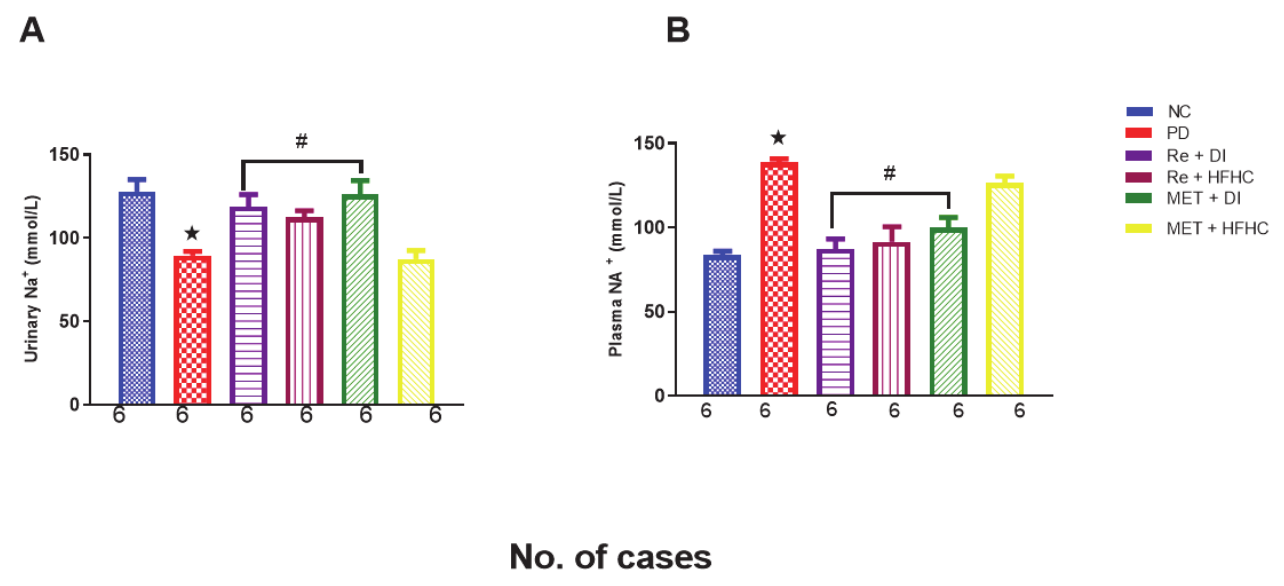
Figure 13. ( A , B ) Urinary and plasma NA + concentration in normal control (NC), prediabetic control (PD), metformin and diet intervention (MET + DI), metformin and high-fat/high-carbohydrate diet (MET + HFHC), rhenium (V) compound and diet intervention (Re + DI) and rhenium (V) compound and high-fat/high-carbohydrate diet (Re + HFHC) groups after 12 weeks of treatment. Values are presented as means ± SEM (n = 6). (cid:70) p < 0.05 in comparison with NC; # p < 0.05 in comparison with PC, MET + DI, MET + HFHC, Re + DI and Re + HFHC.